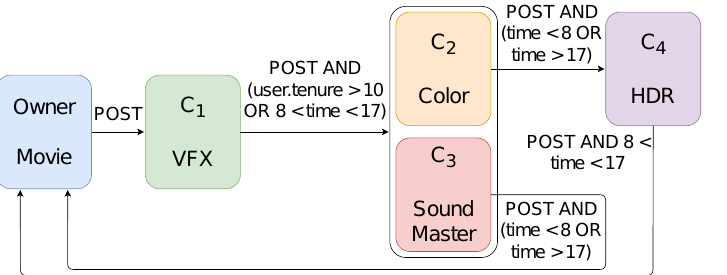
Figure 8. Movie workflow: special effects apply before color tuning and sound mastering. HDR is set up last.